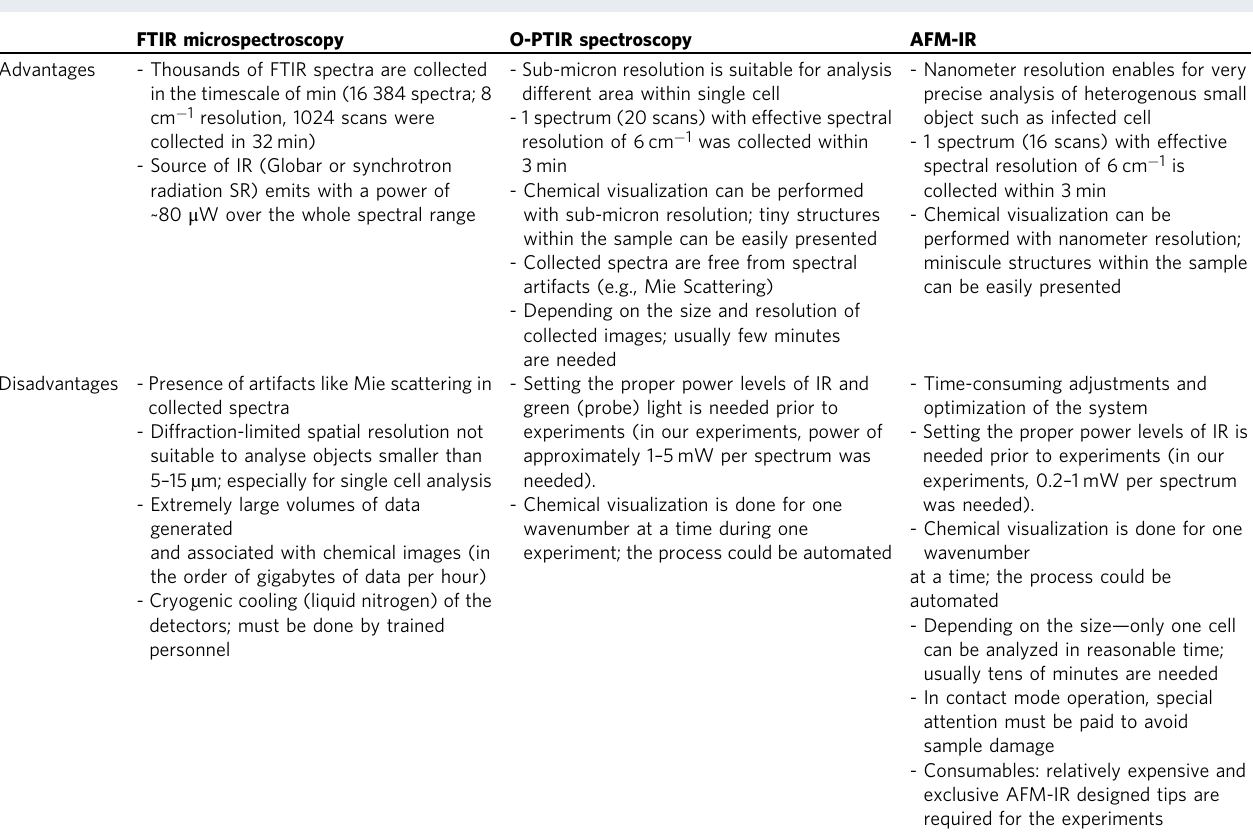
Table 1 Practical advantages and disadvantages of the spectroscopic methods observed from our analysis of individual Plasmodium- infected